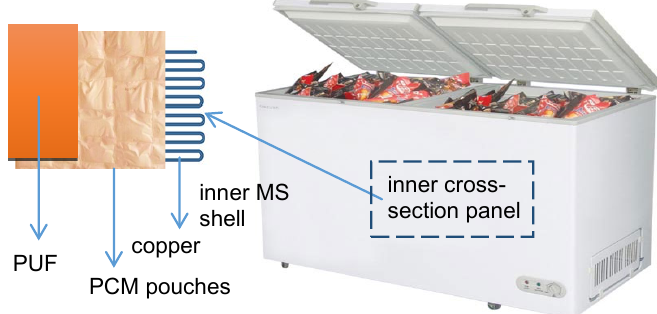
Figure 8. Freezer/cooler (source: PLUSS Advanced Technologies Ltd.).